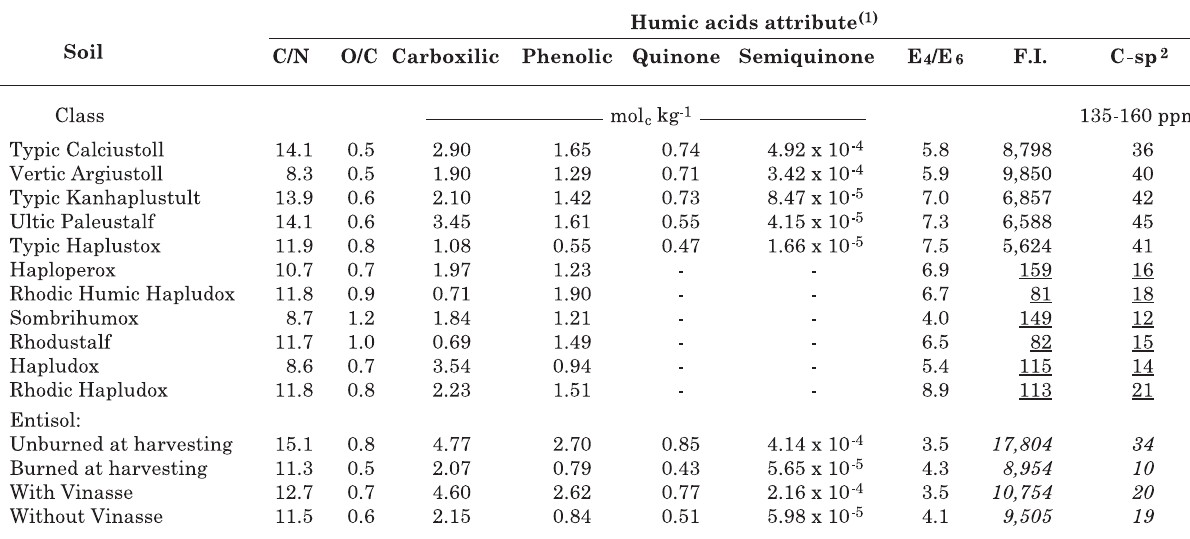
(1) C/N and O/C: ratios from elementary composition; Carboxilic, phenolic and quinone functional groups; Semiquinone: free radicals;